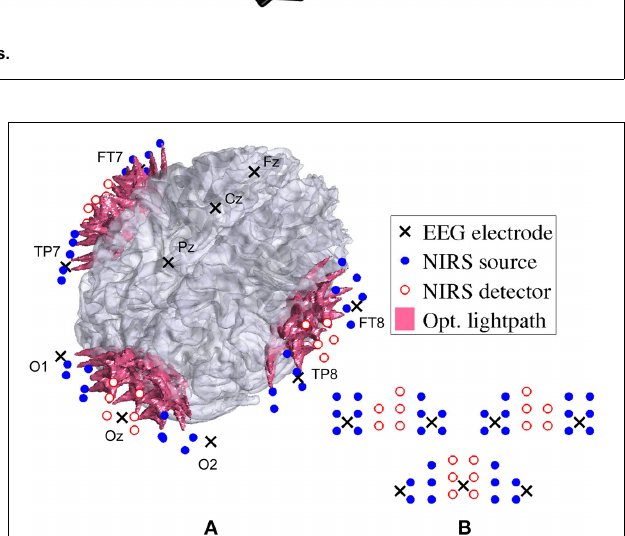
FIGURE 3 | Locations of EEG electrodes, fNIRS optrodes, and their corresponding optical lightpath. The arrangement of fNIRS sources and detectors is shown projected on the brain in (A) and as unwrapped schematic in (B) for the two auditory probes (top left and right) and the visual probe